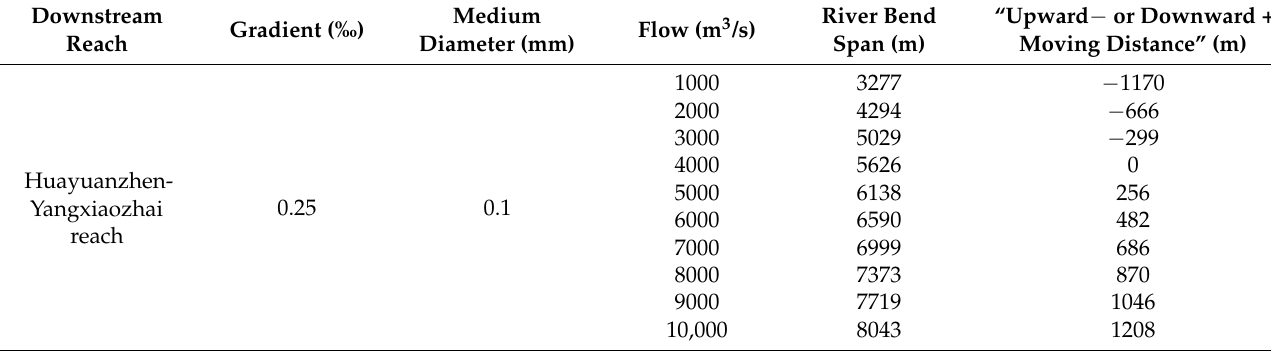
Table 2. Calculated results of the upward or downward moving distances of main stream zone at Huayuanzhen- Yangxiaozhai